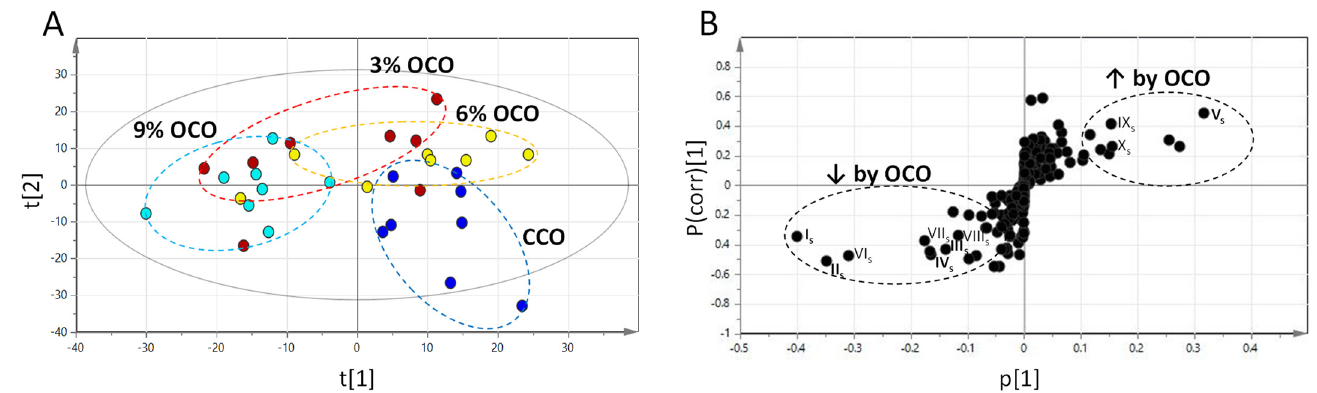
Figure 1. Profiling oxidized corn oil (OCO)-induced changes in serum amino acids. Data from LC-MS analysis of serum samples were processed by multivariate modeling. ( A ) Scores plot of the PLS-DA model on serum samples. ( B ) S-plot of the OPLS-DA model on serum samples. The identified OCO-responsive metabolites are labeled (I s –X s ). Table 2 . Confirmed oxidized corn oil (OCO)-responsive amino-containing metabolites in serum. The metabolites were detected in positive mode after the DC derivatization ([M+DC] + ) and identi- fied as the markers from multivariate modeling.